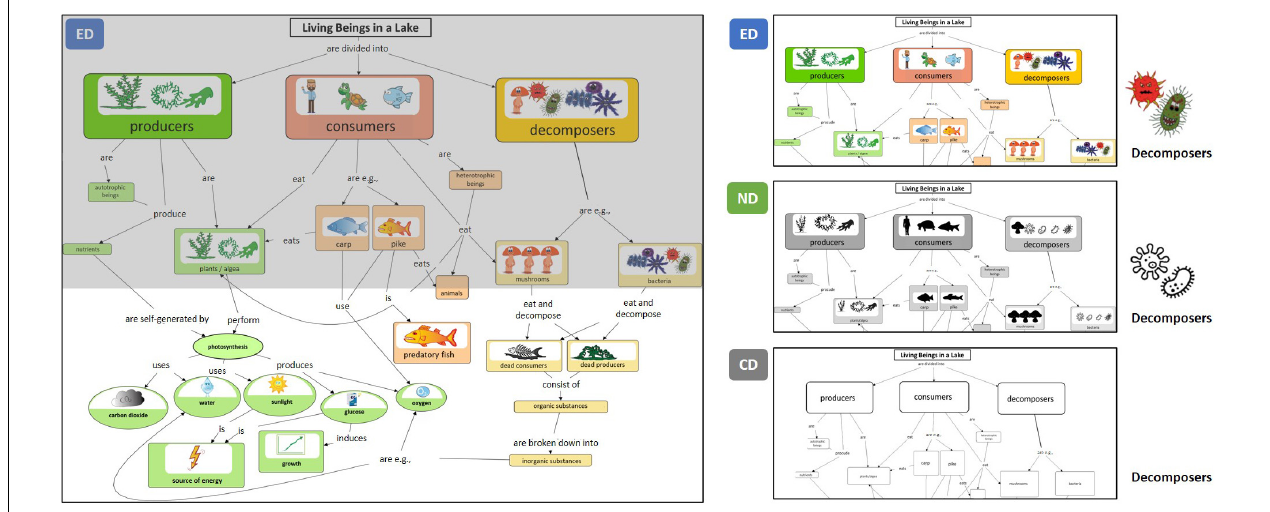
FIGURE 1 | Concept map for “Living Organisms in a Lake” (translated from German) in emotional design (ED) (left) . Gray area of the concept map is displayed enlarged (middle) for the emotional design, the neutral design (ND), and the control design (CD). The concept “Decomposers” is shown in detail (right)